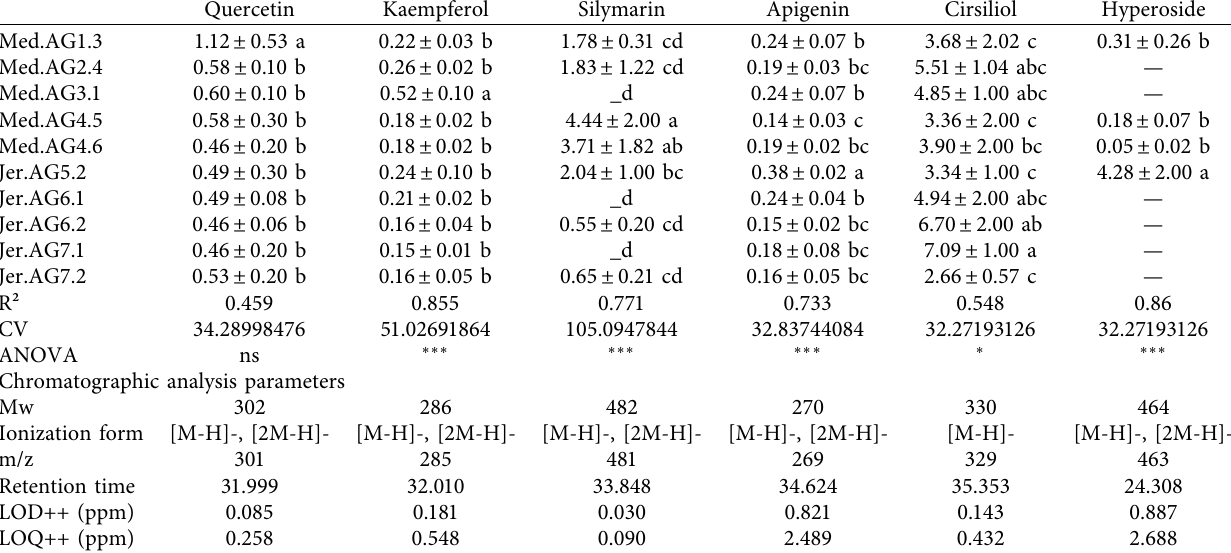
Table 5: Flavonoid compounds ( µ g · g − 1 DM) identified in the methanol extracts of grains of millet genotypes.